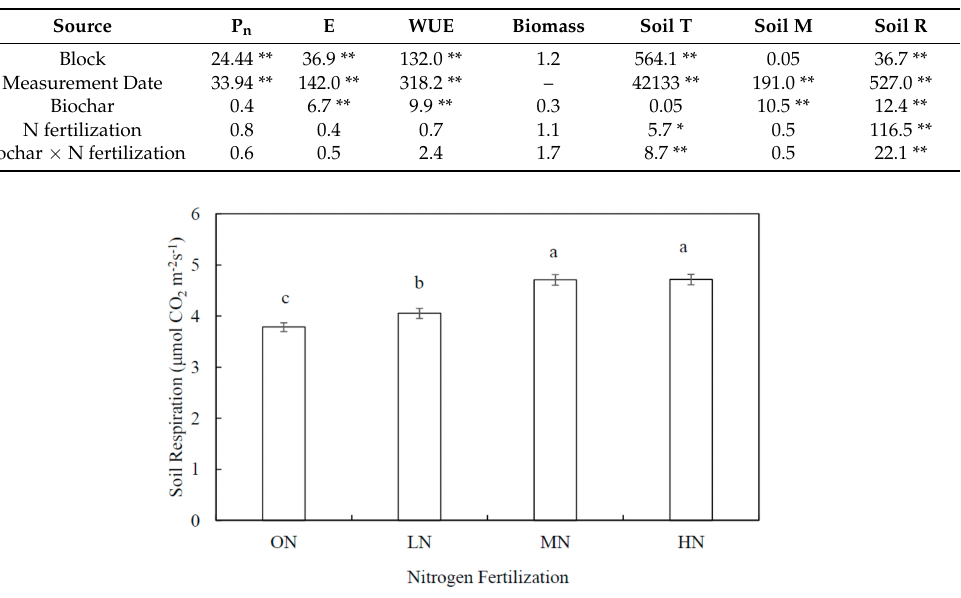
Table 1. Significance of the effects of measurement date, biochar, N fertilization and interaction of biochar and N fertilization on leaf maximum photosynthesis (P n ), transpiration (E), water use efficiency (WUE),